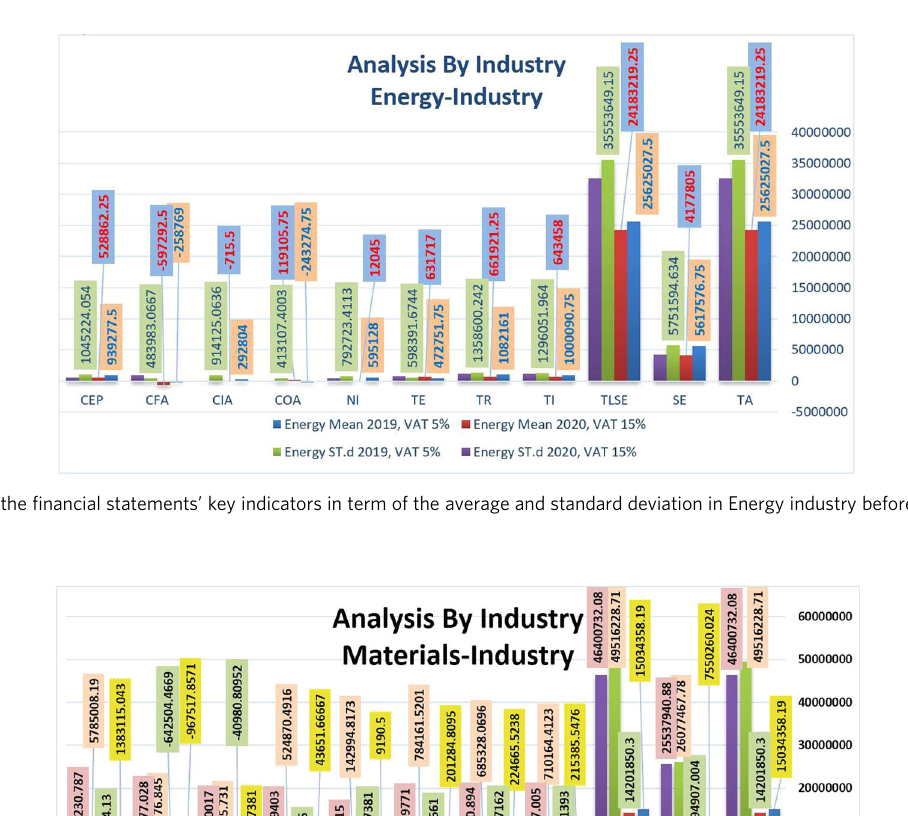
Table 2 Increase or decrease in values of fi nancial statements ’ key indicators in terms of the average between the Energy and Materials